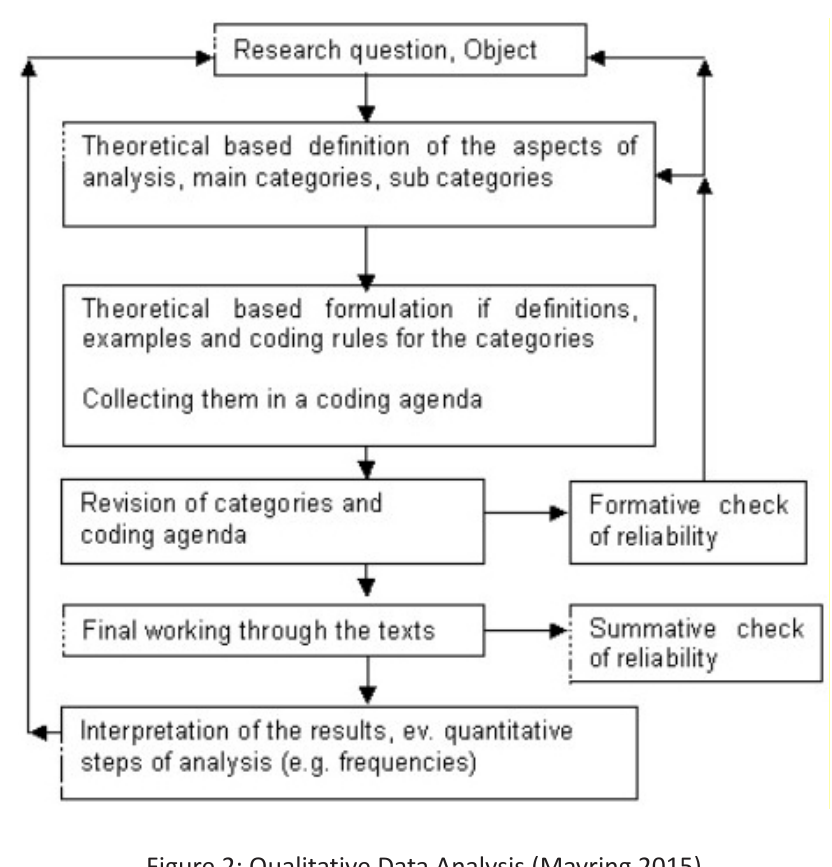
Figure 2: Qualitative Data Analysis (Mayring